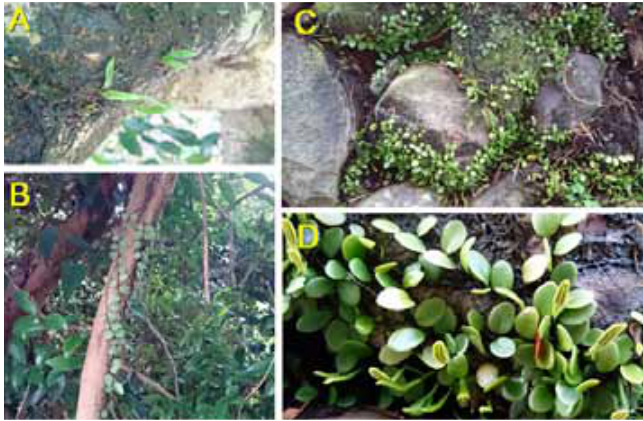
Fig. 4 - Epiphytic ferns found in a countryside private garden (Kiyotake- cho, Miyazaki, Japan). (A) Lepisorus thunbergianus grown on the trunk of a loquat tree ( Eriobotrya japonica (Thunb.) Lindl.). (B- D) Lemmaphyllum microphyllum growing on the tree and rocks.